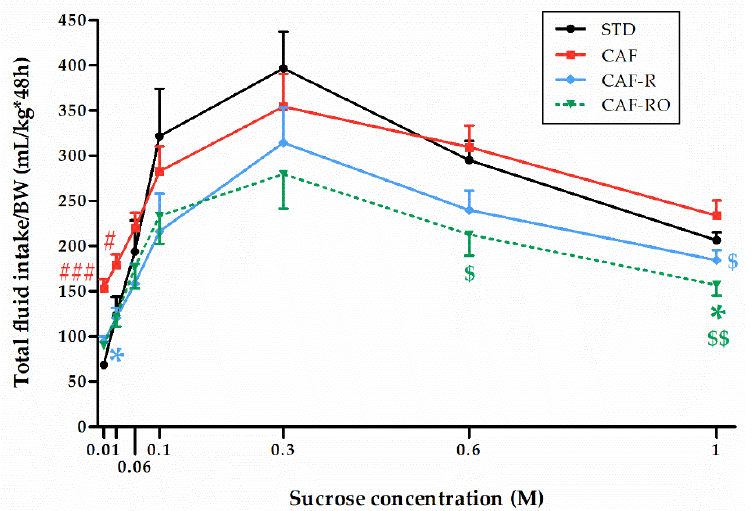
Figure 3. Effects of the dietary treatments on the total fluid intake during the two-bottle preference test. Total fluid intakes (mL) were relativized to the body weight (BW, kg). Data are expressed as the mean ± SEM. * p < 0.05 vs. STD group; $ p < 0.05, $$ p < 0.01 vs. CAF group; # p < 0.05, ### p < 0.001 vs. all groups.